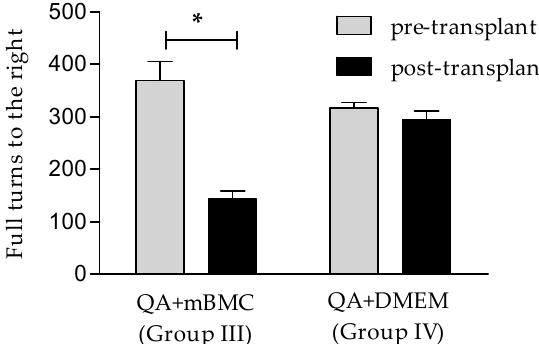
Figure 1. Rotatory activity induced under D-amphetamine. Lesioned group with quinolinic acid + mononuclear bone marrow cell transplant (QA + mBMC, Group III) and lesioned group with QA + Dulbecco’s modified Eagle’s medium (DMEM) transplant (QA + DMEM, Group IV). Abscissa, number of complete right turns ipsilateral to the lesioned hemisphere. Data are expressed as mean ± standard error of mean (SEM). Ordinates: experimental groups (* equivalent p ≤ 0.04).